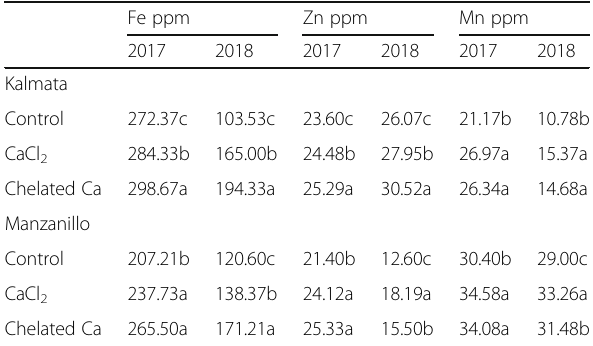
Table 4 Effect of foliar spray with some calcium sources on nitrogen (N), phosphor (P), potassium (K), and calcium (Ca) contents in leaves of olive Kalmata and Manzanillo cultivars